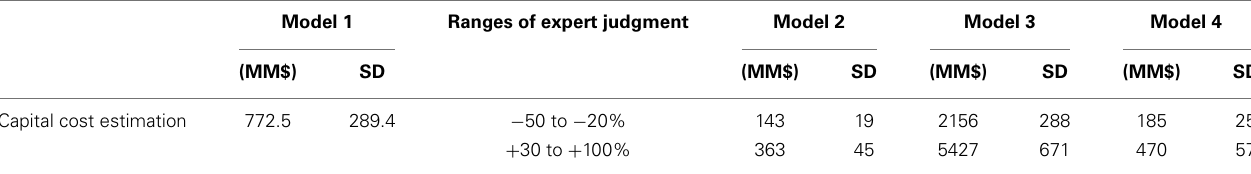
Table 6 |The comparison of early-stage cost estimation for an ethylene production plant of 1300 tpd . Model 1 Ranges of expert